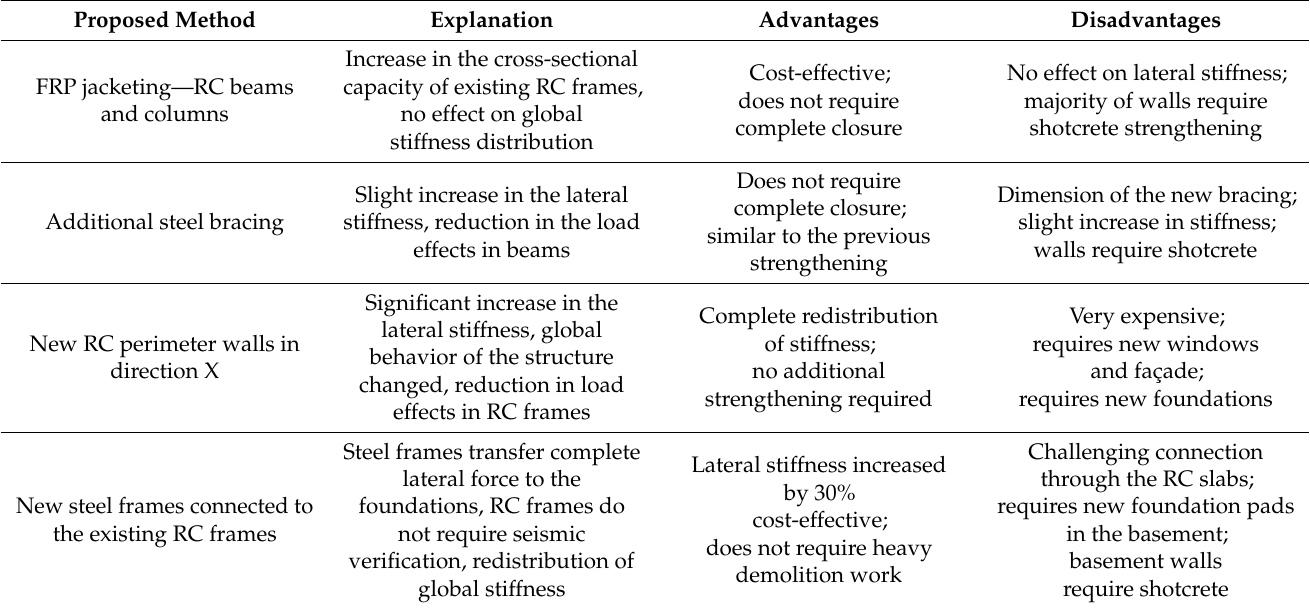
Table 12. Summary of the proposed strengthening